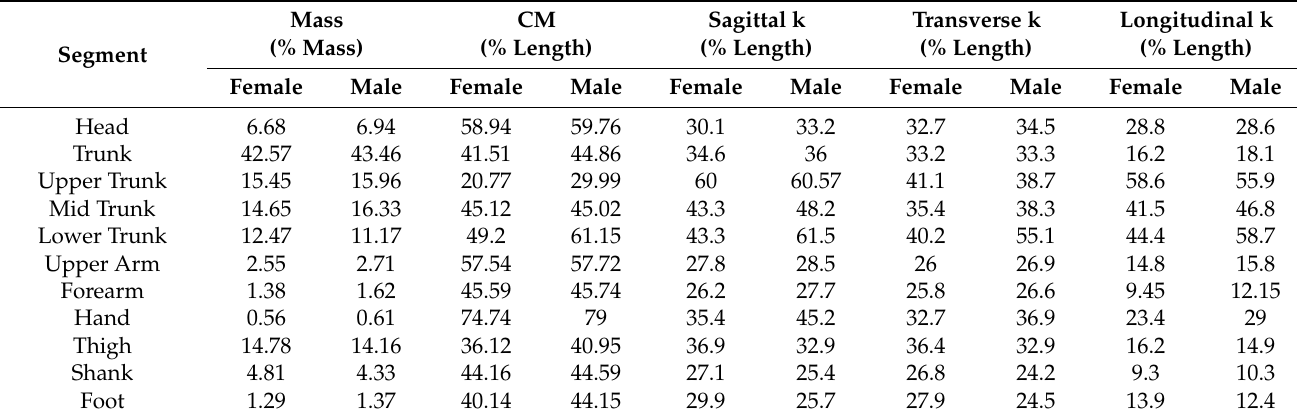
Table 1. Percentage values of mass and position of the center of gravity in adult men and women [30,31] (copyright has been permitted).